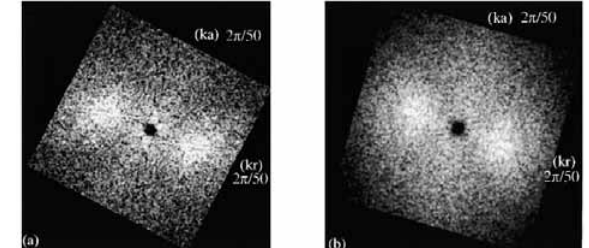
Fig. 6: Two-dimensional linear dune wave number spectra derived from JERS-1 SAR and ERS-1 AMI images in the study area. (a) Wave number spectrum derived from JERS-1 SAR image. (b)Wave number spectrum derived from ERS-1AMI image. k a and kr are the azimuth and range wave number of the power spectrum at peak frequency (Qong, 2000).